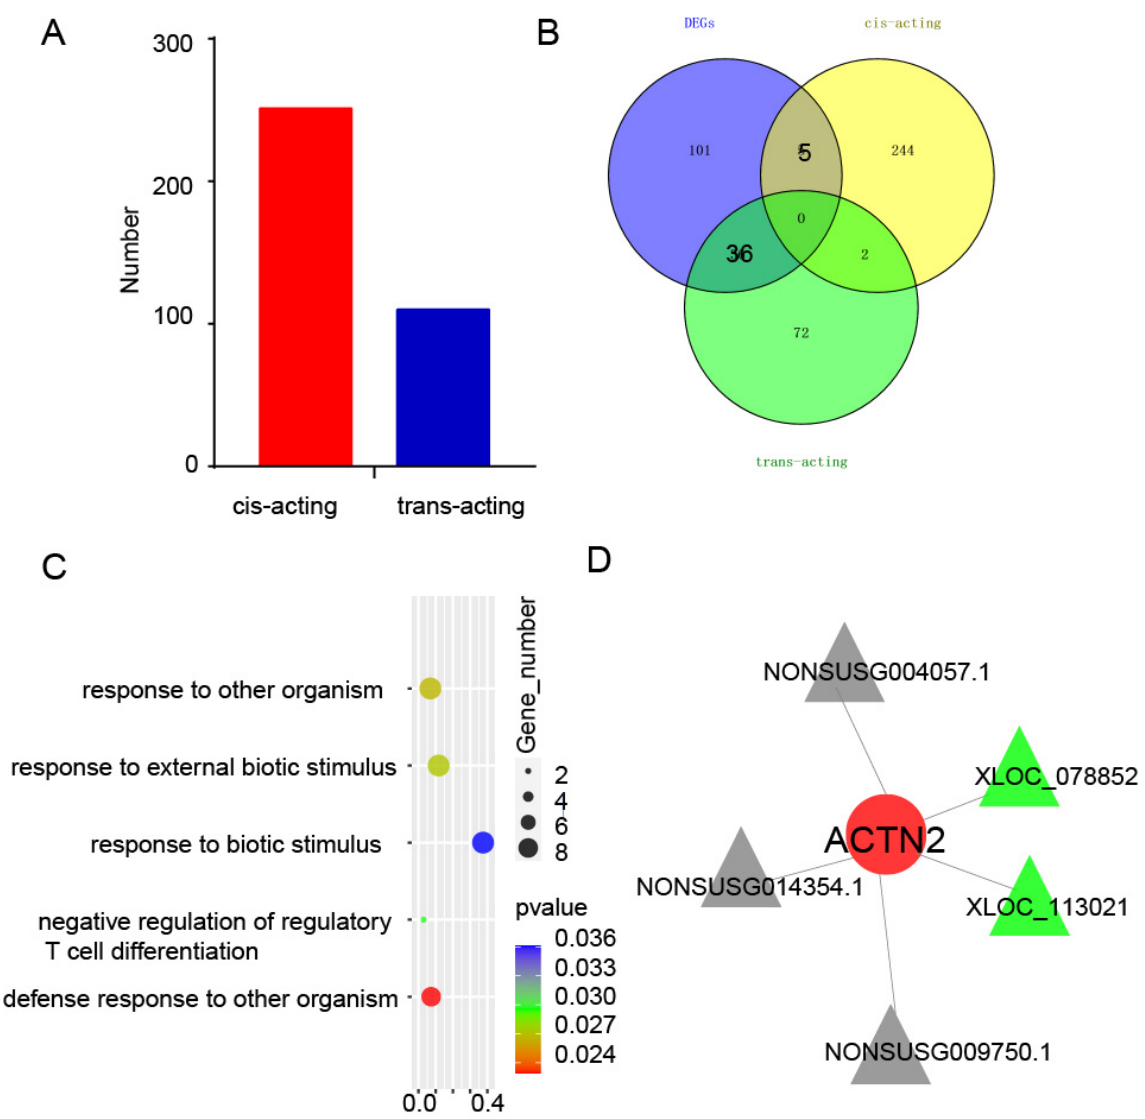
Figure 5. lncRNAs in spleen development in ZBED6 KO pigs. ( A ) Number of cis- and trans-acting genes of lncRNA. ( B ) Venn diagram of DEGs, cis- and trans-acting genes. ( C ) Enriched gene pathway terms of 40 overlapping genes in Figure 5B. ( D ) Function network of ACTN2. Red indicates key gene ACTN2, green indicates known lncRNAs, and gray indicates potentially novel lncRNA .